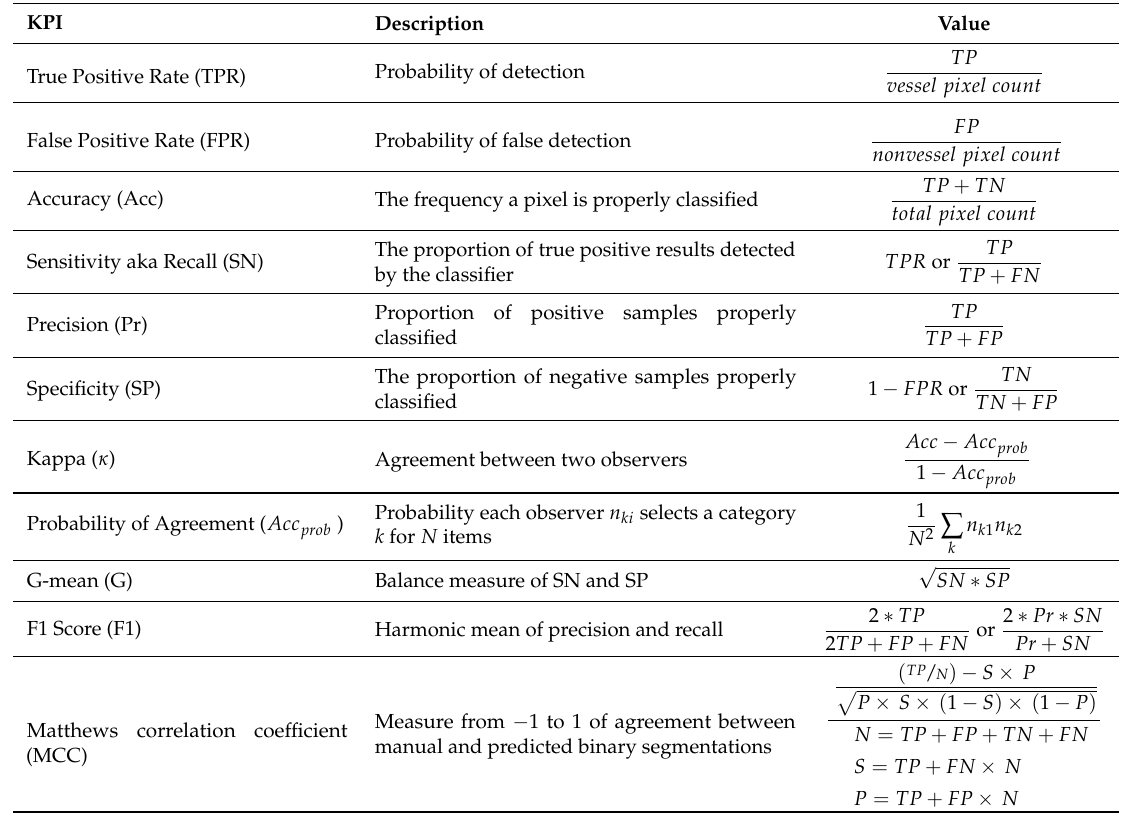
Table 1. Key performance